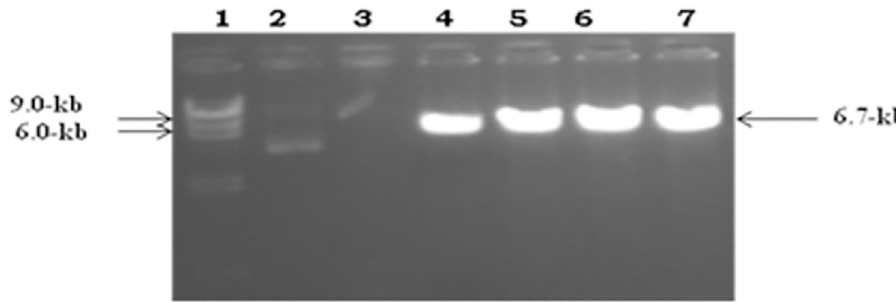
Fig 5. Linearization of vector pcDNA3.1+/P2X4 before transfection. Lane 1 showed: λ HindIII digested marker, Lanes 4, 5, 6 and 7 showing digested linerized plasmid pcDNA3.1+/P2X4 (6.7-kb).